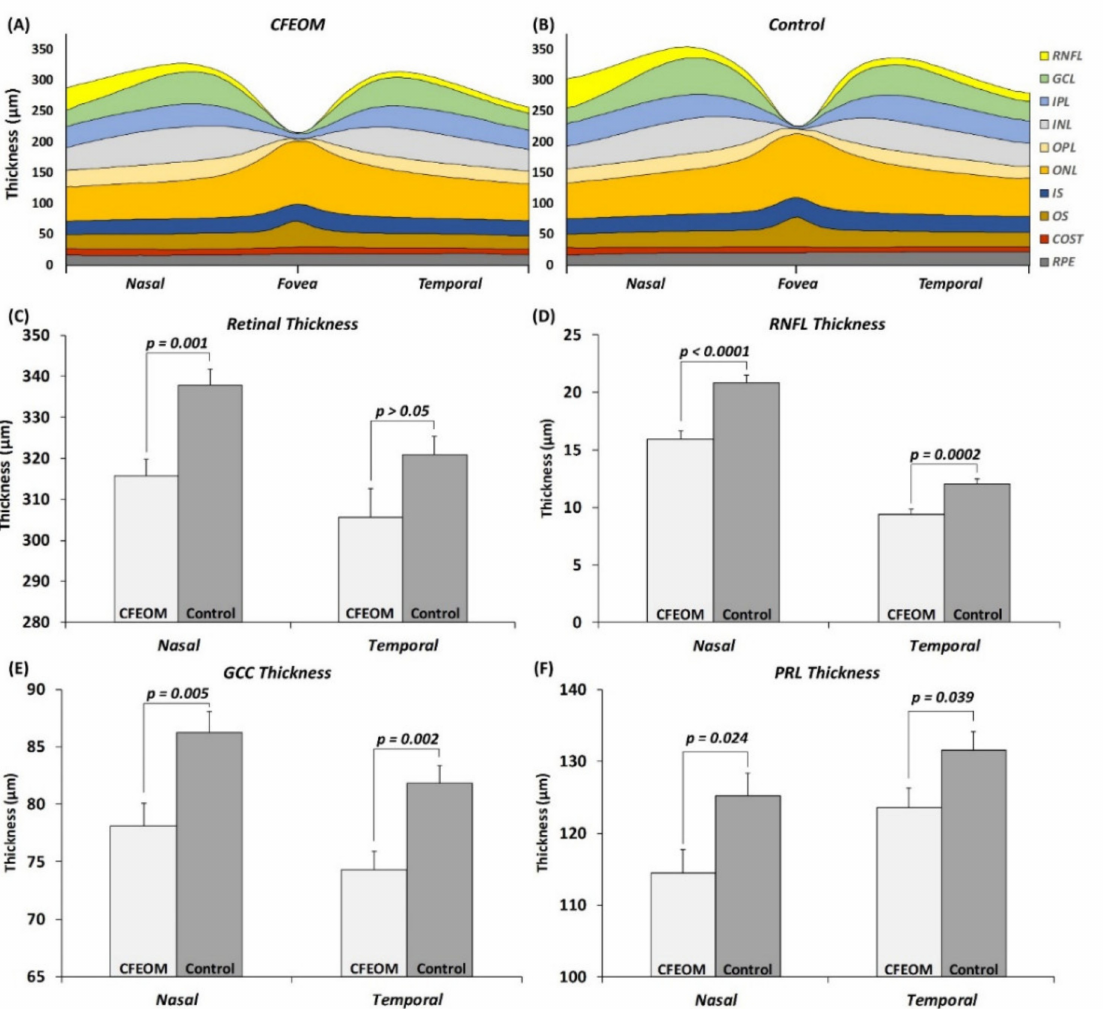
Figure 5. Schematic representation of average thickness of each retinal layer in CFEOM ( A ) and controls ( B ). Significant differences were observed for nasal retinal thickness ( C ), retinal nerve fiber layer (RNFL) ( D ), ganglion cell complex (GCC) ( E ), and photoreceptor layer (PRL) thickness ( F ). Bar charts represent mean and standard error ( µ m). p values are shown above each bar. Abbreviations: RNFL = retinal nerve fiber layer, GCL = ganglion cell layer, IPL = inner plexiform layer, INL = inner nuclear layer, OPL = outer plexiform layer, ONL = outer nuclear layer, IS = inner segment, OS = outer segment, COST = cone outer segment tip, and RPE = retinal pigment